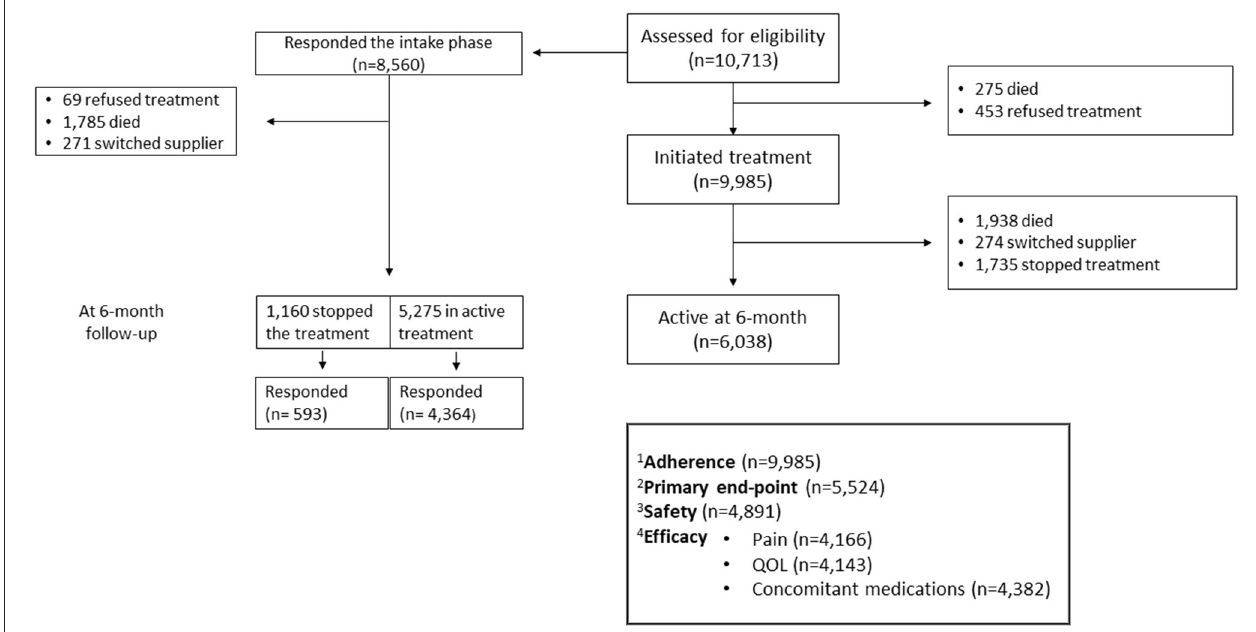
FIGURE 1 | The study population. Detailed description of the patients included into the adherence assessment, primary endpoint assessment, and the safety and effectiveness analysis population. 1 Adherence analysis was performed on all patients who initiated treatment. 2 Primary end-point analysis was performed on patients who responded the intake questionnaire and: responded to the 6-month follow-up questionnaire and all patients who stopped the treatment. 3 Safety analysis was performed on all patients who responded to the side-effect section of the 6-month follow-up questionnaire, both active patients and responders that stopped the treatment. 4 Efficacy analysis was performed on patients who answered the specific chapter at the intake session and at the 6-month follow-up questionnaire (active patients